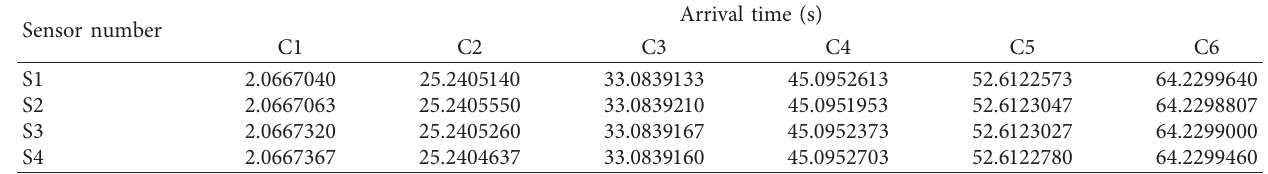
Table 11: First arrival time of the pulse sources for Scheme I of G3761-L.